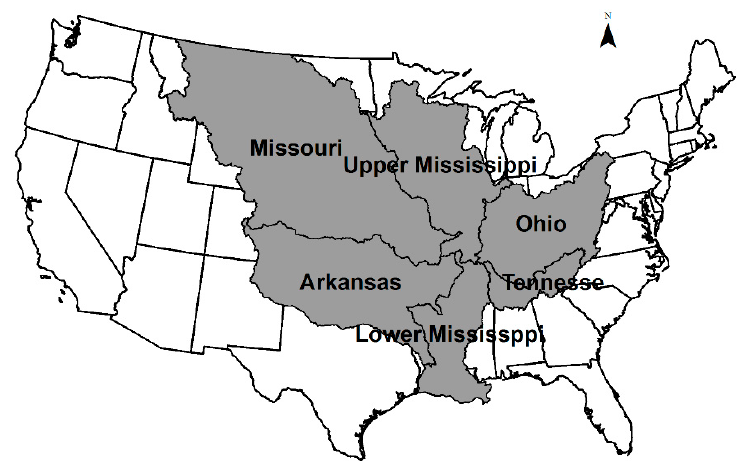
Figure 1. River basins used in SPARROW.